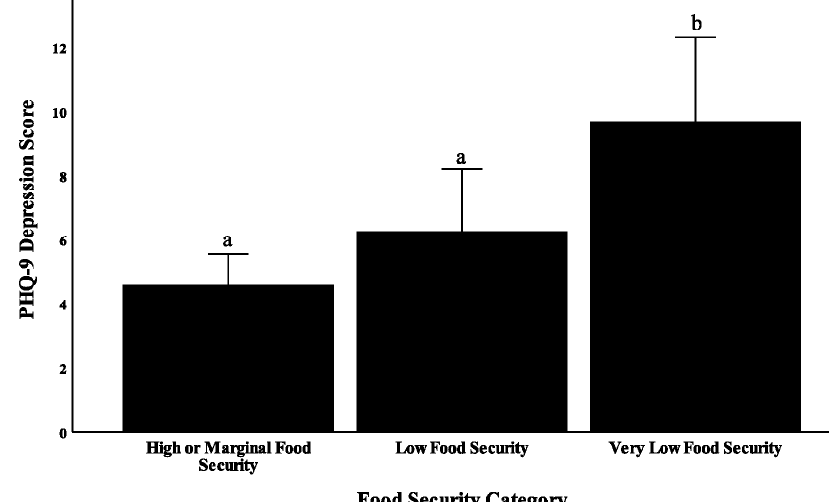
Figure 1. Food security and depression in college students at Mississippi State University. Students with very low food security scored significantly higher on the PHQ-9 than students with low food security ( p = 0.016) and students with high or marginal food security ( p < 0.001). Di ff erent letters on the graph indicate a statistically significant di ff erence with a p -value less than 0.05 (ANOVA with Tukey post-hoc